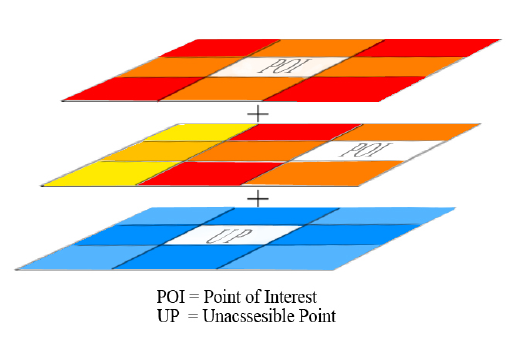
tion. Notice, every point has a fitness value.